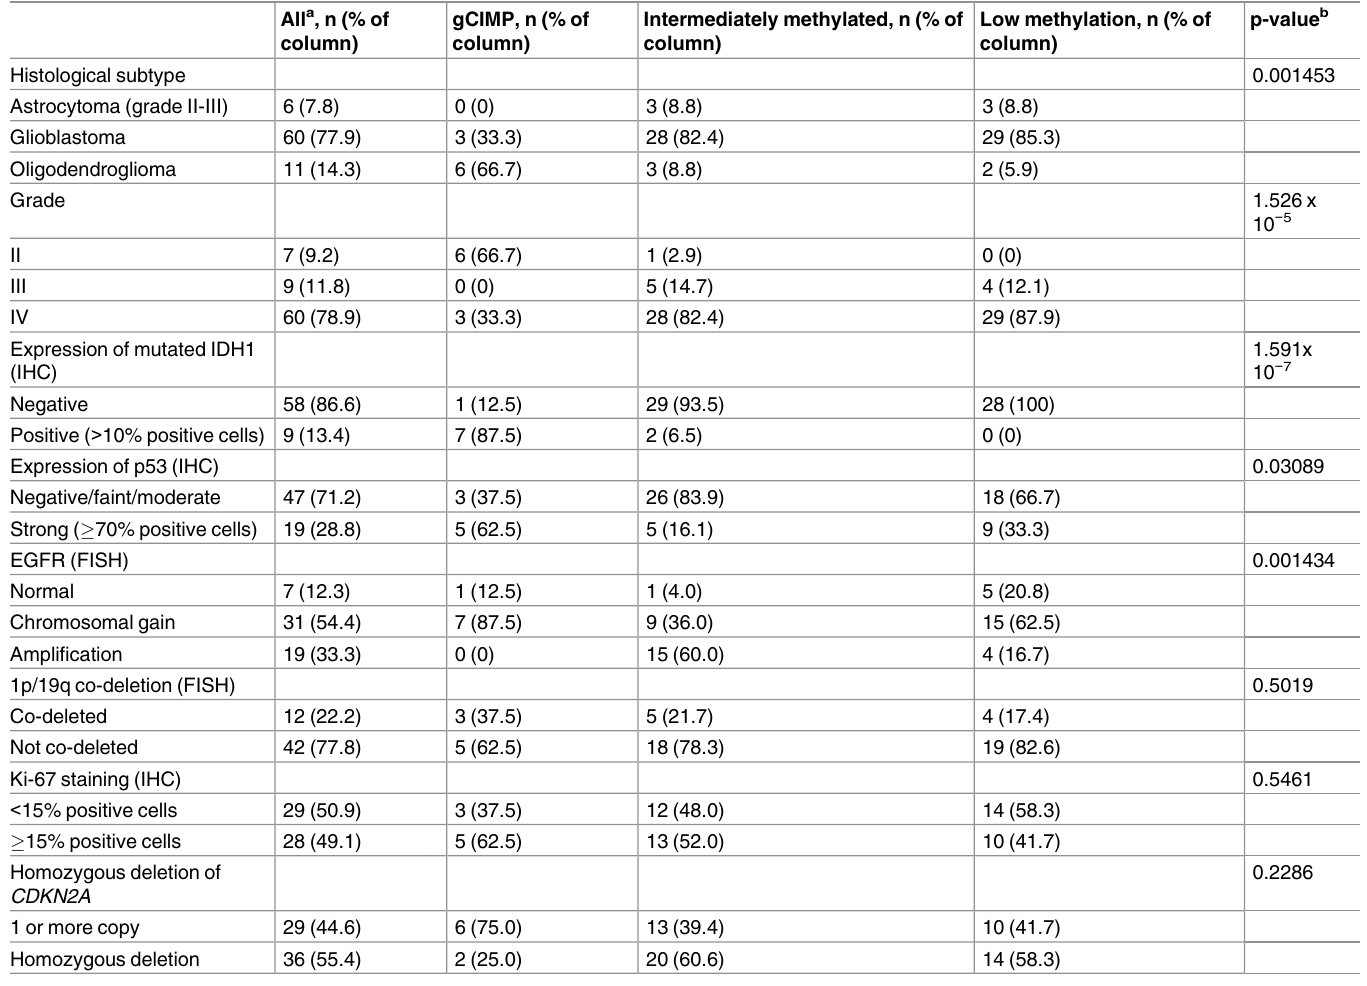
Table 1. Tumor characteristics.